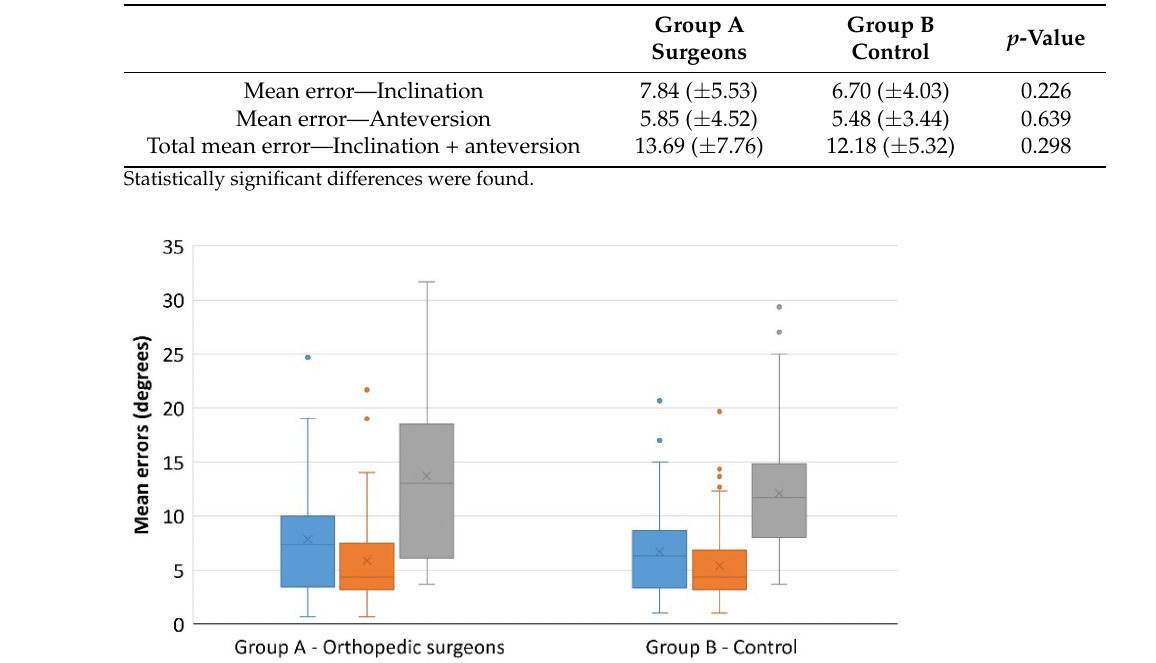
Table 3. Mean errors (degrees) in test 3.